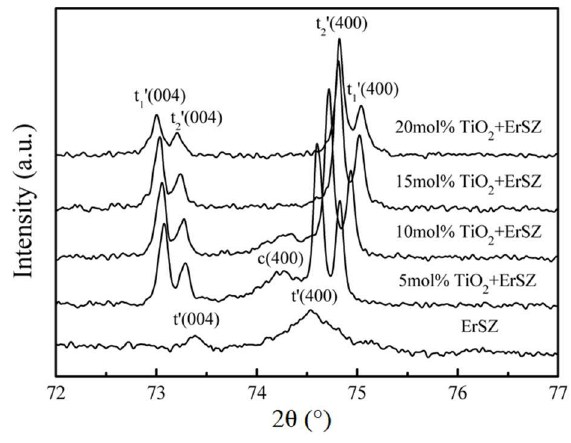
Figure 2. X-ray diffraction peaks of TiO 2 doped ErSZ at 2 θ = 72 ◦ –76 ◦ by slow scans. Table 1. Phase compositions of 10 mol %, 15 mol %, and 20 mol % TiO 2 -doped